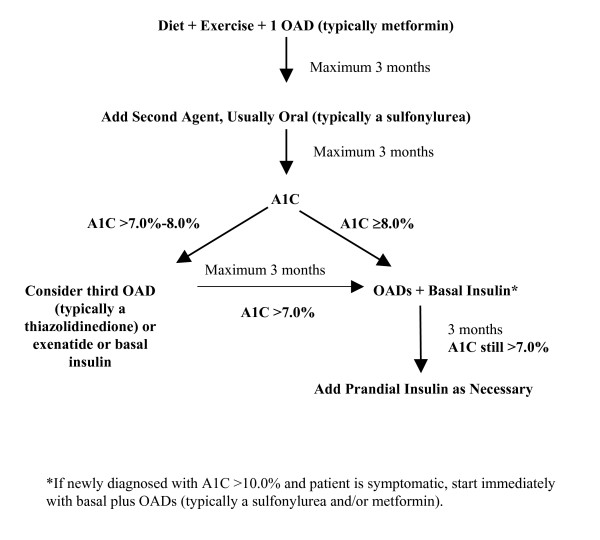
Type 2 diabetes treatment algorithm.